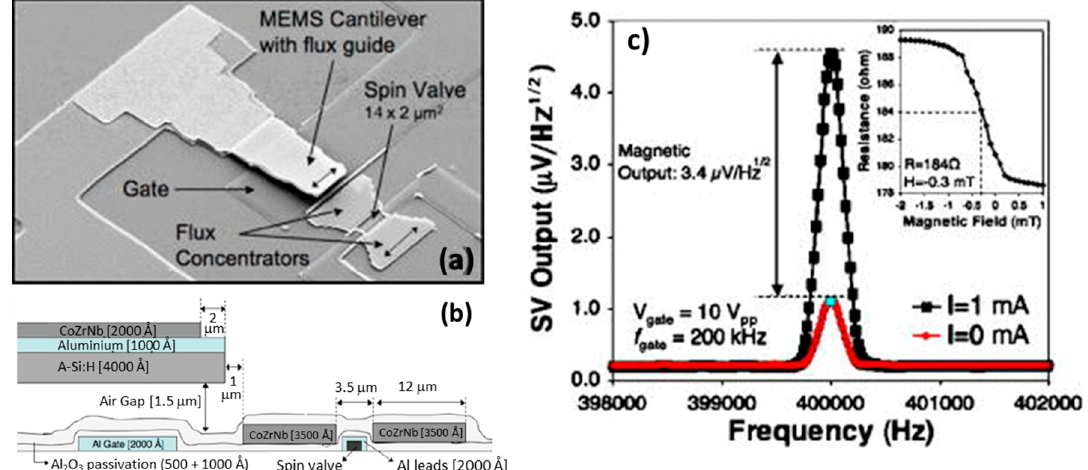
Figure 7. ( a ) SEM image of the hybrid device showing the integration of a SV sensor with static MFCs and a single MEMS cantilever resonator (with an additional MFC on top); ( b ) Schematic view of the device cross section; ( c ) SV voltage output exhibiting both electric (capacitive coupling) and magnetic components when the cantilever resonates at a frequency of 200 kHz. Reprinted with permission from A. Guedes et al. , J. Appl. Phys . 2008, 103 , 07B924. Copyright 2008 AIP Publishing LLC.